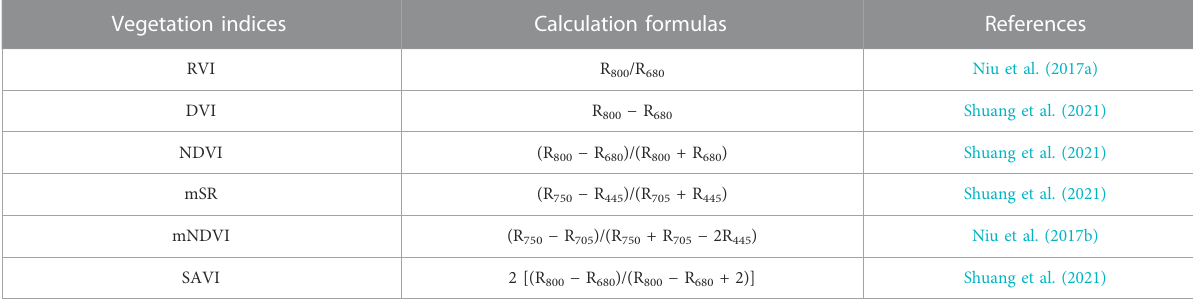
TABLE 2 Vegetation indices and their respective calculation formulas. Vegetation